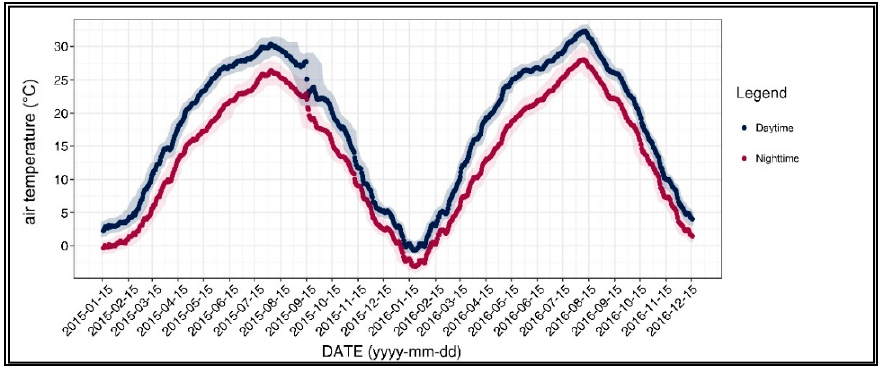
Figure 2. Air temperature of the 31-day moving average.